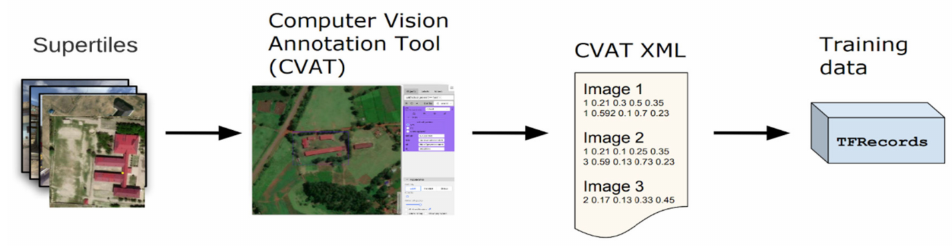
Figure 10. Training data generation for Kenya direct school detection.